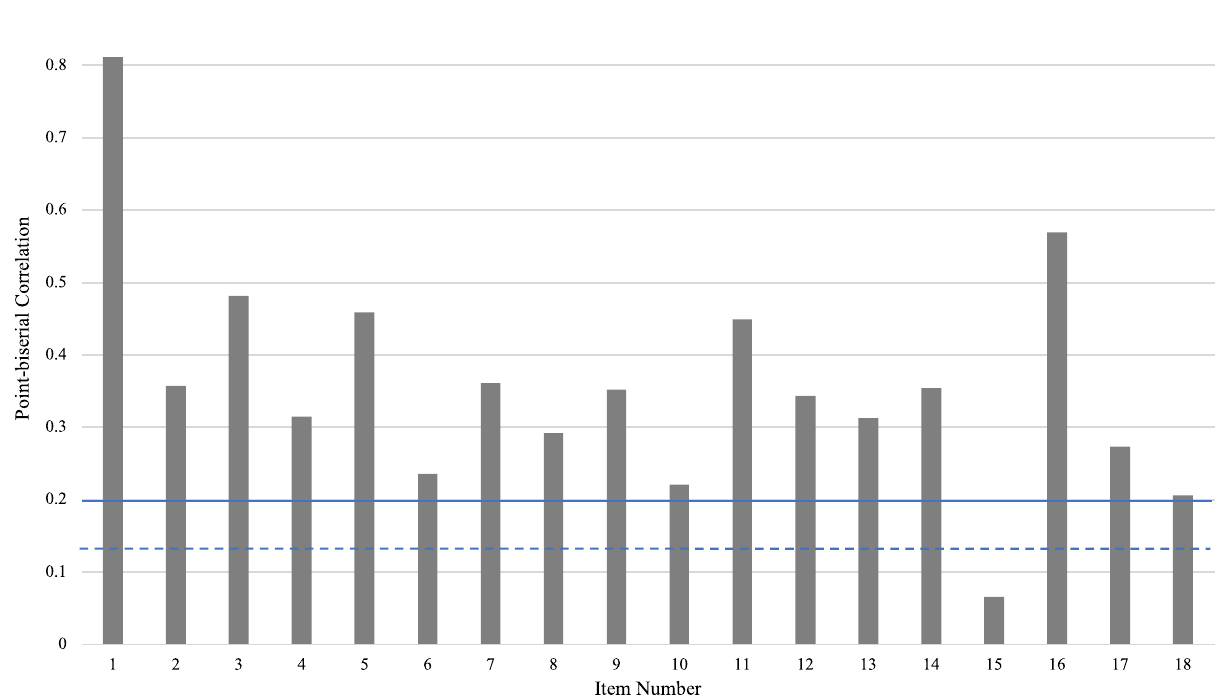
FIG. 6. Post-test item discrimination ( r acceptable. The horizontal blue line is at r